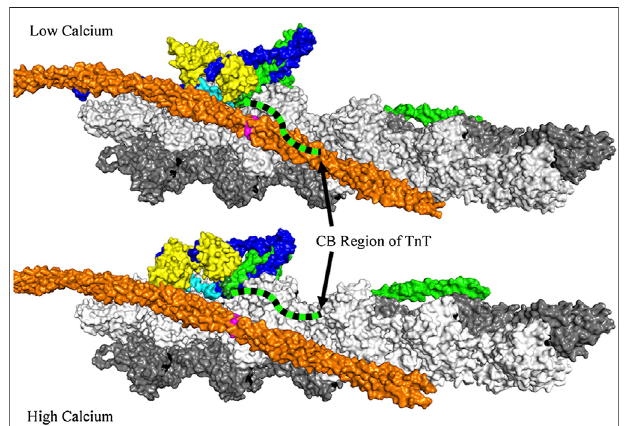
FIGURE 1 | View of actin (grey and white), tropomyosin (orange), TnT (green), TnC (yellow) and TnI (blue) with the inhibitory region of TnI (light blue). Also shown are Cys 190 of tropomyosin (pink) and Cys 374 of actin (black). The coordinates for this fi gure were taken from PDB deposition 6kn7 (lowcalcium)and6kn8(highcalcium)(Yamadaetal.,2020).Superimposedon this fi gure is a possible location of the C-terminal basic region of TnT (green dashed ribbon). This ribbon extends from the end of the IT helix. Both the inhibitoryregionofTnIandtheC-terminalbasicregionofTnTmoveawayfrom actin-tropomyosin in the Ca 2+ -bound state. Actin fi laments containing HAHA TnT at low free Ca 2+ would resemble the wild type at high Ca 2+ in some respects (see text). Note that the tropomyosin and troponin on the opposite face of the actin fi lament are not shown for